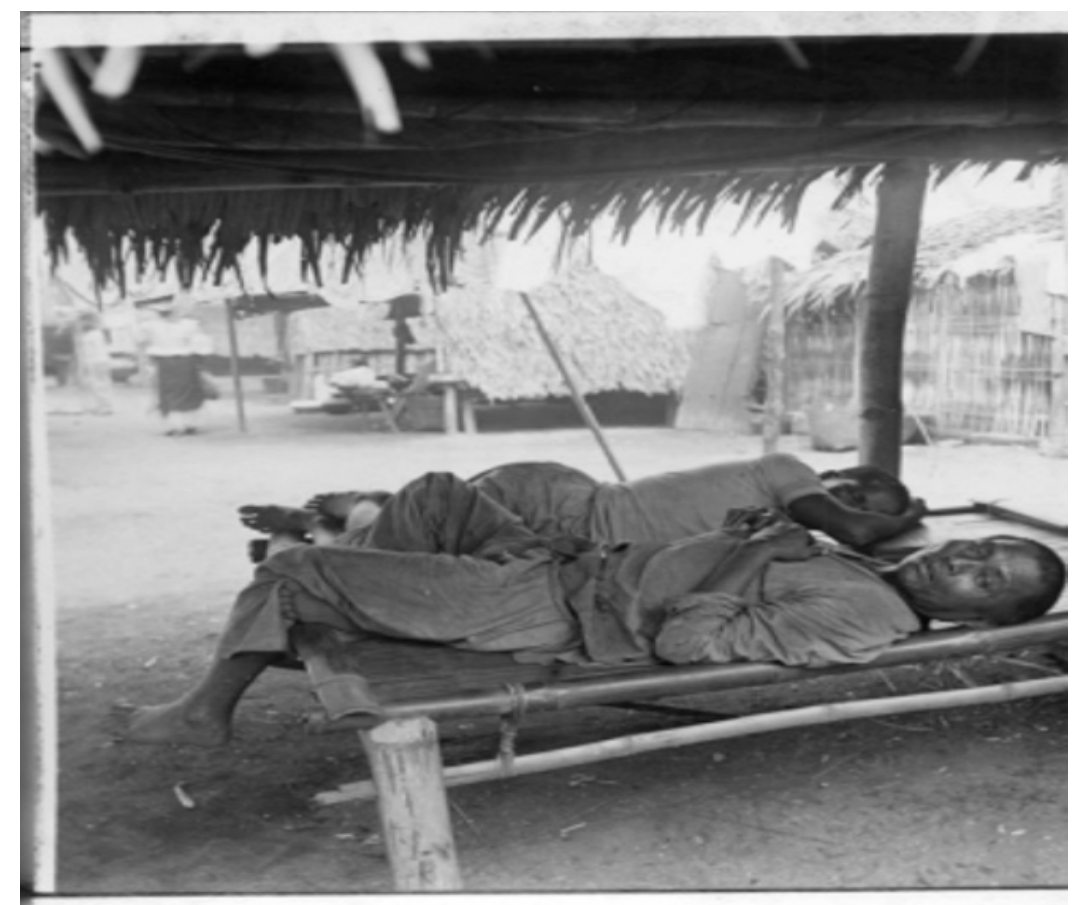
Figure 6. Sweet Repose, How the Filipinos Sleep Figure 6 Sweet Repose, How the Filipinos Sleep (1898–1930) .